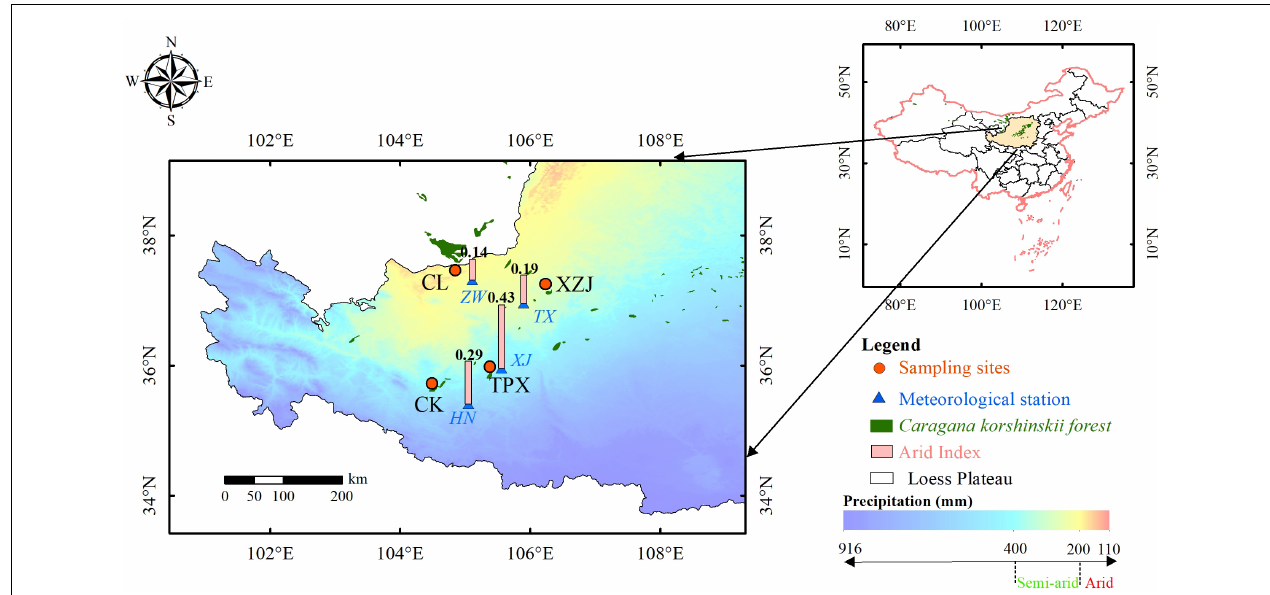
FIGURE 1 | Map of the sampling sites and nearest meteorological stations. TABLE 1 | Environmental characteristics of each sampling site. Sampling